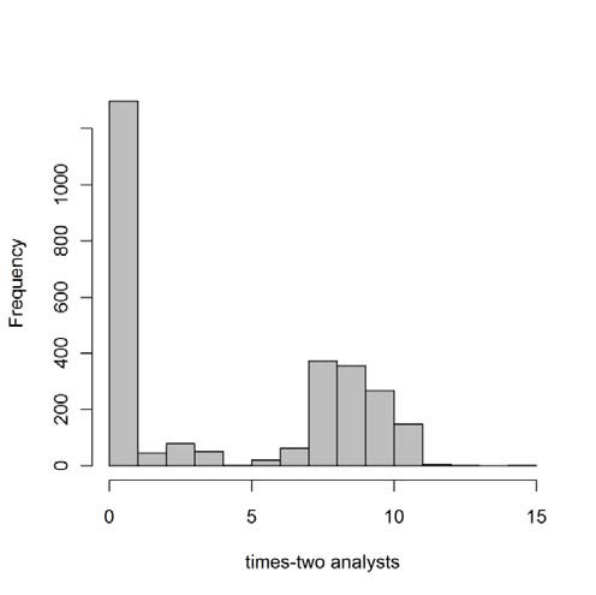
Fig. 2. Histogram of times for two